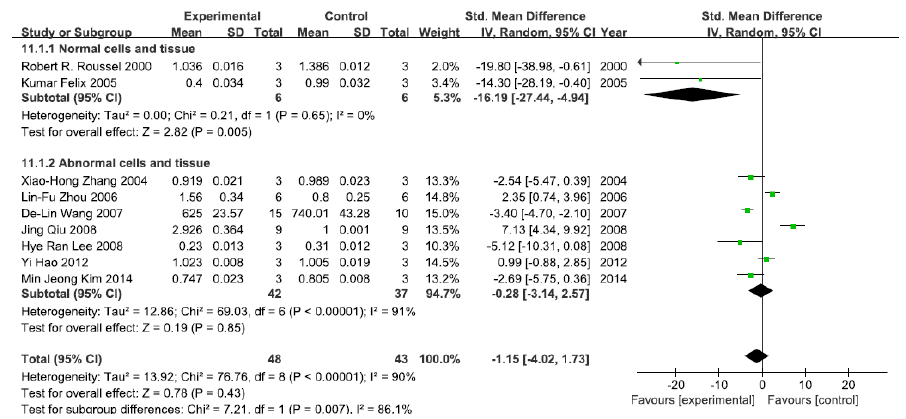
Figure 3. Effects of arsenic on inhibitor of kappa B(I κ B). Forest plot showing the impact of arsenic treatment on I κ B compared with controls. Abbreviations: SMD = standardized mean difference, IV = independent variable, 95% CI = 95% confidence interval.